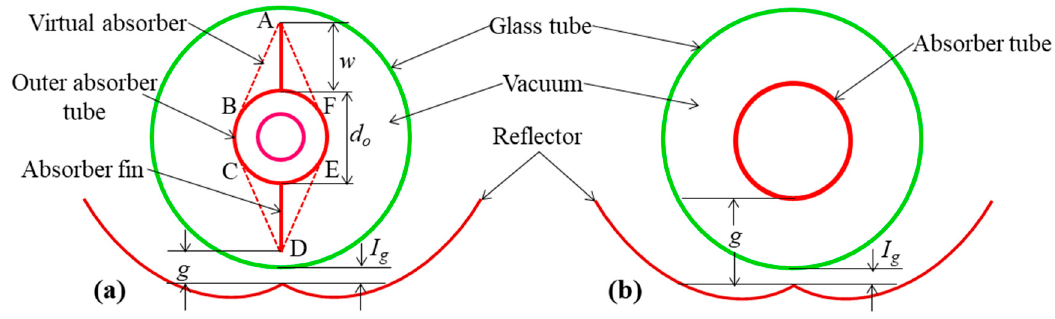
Figure 3. Cross-section of evacuated tube receiver with: ( a ) CT absorber with flat fins and ( b ) SFT absorber.